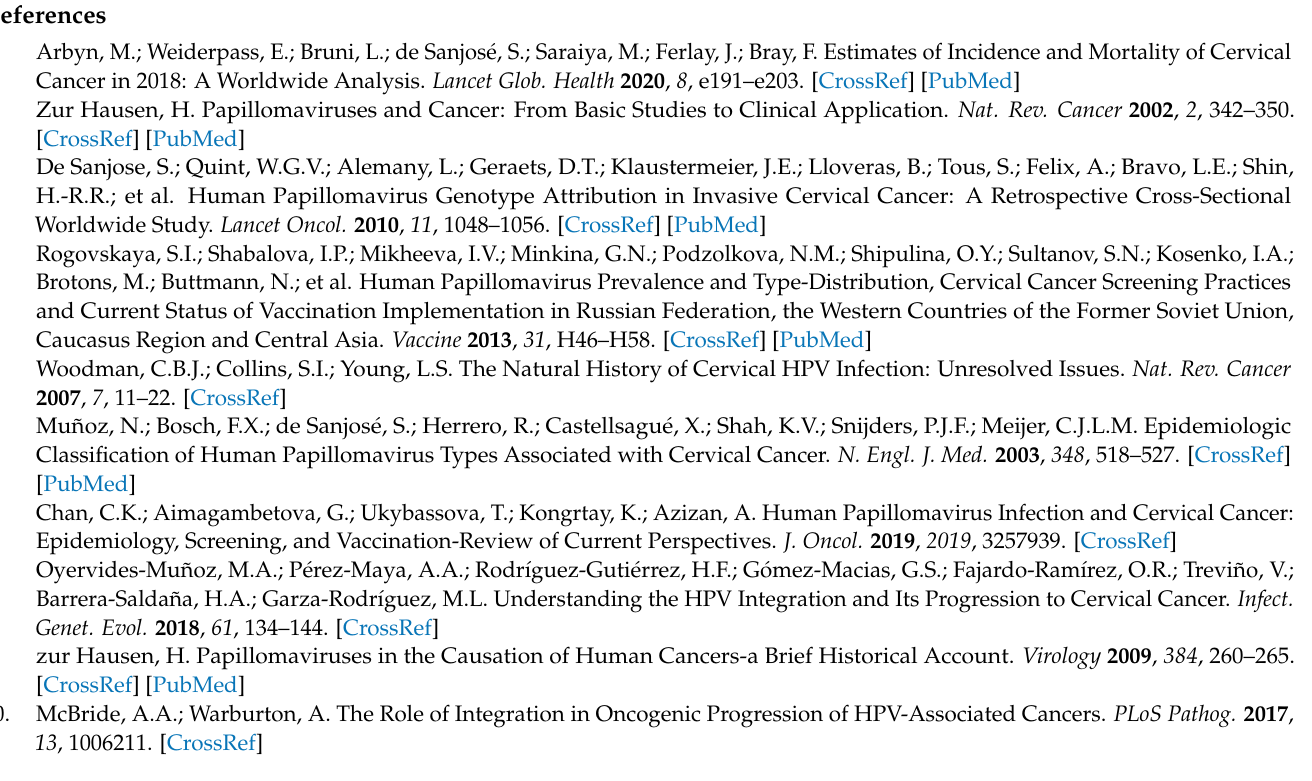
Table S1: Semi-quantitative scoring method for immunohistochemical expression of ANXA2 and CRNN proteins. Table S2: Combined list of proteins identified from orbitrap and timsTOF MS. Table S3: Lists of the differentially expressed proteins between the normal cervix, HPV-associated SIL and HPV-associated SCC groups. Table S4: Demographic and pathology information of the